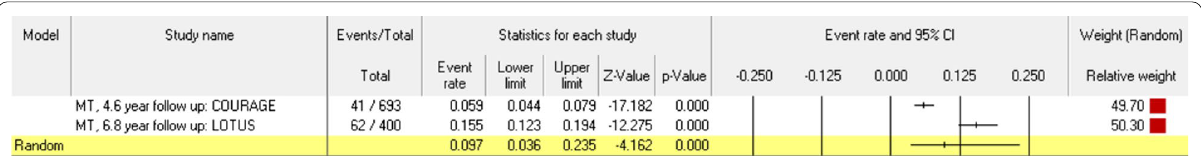
Fig. 4 Death probabilities after MT in CAD patients under 60 years old during 5.4